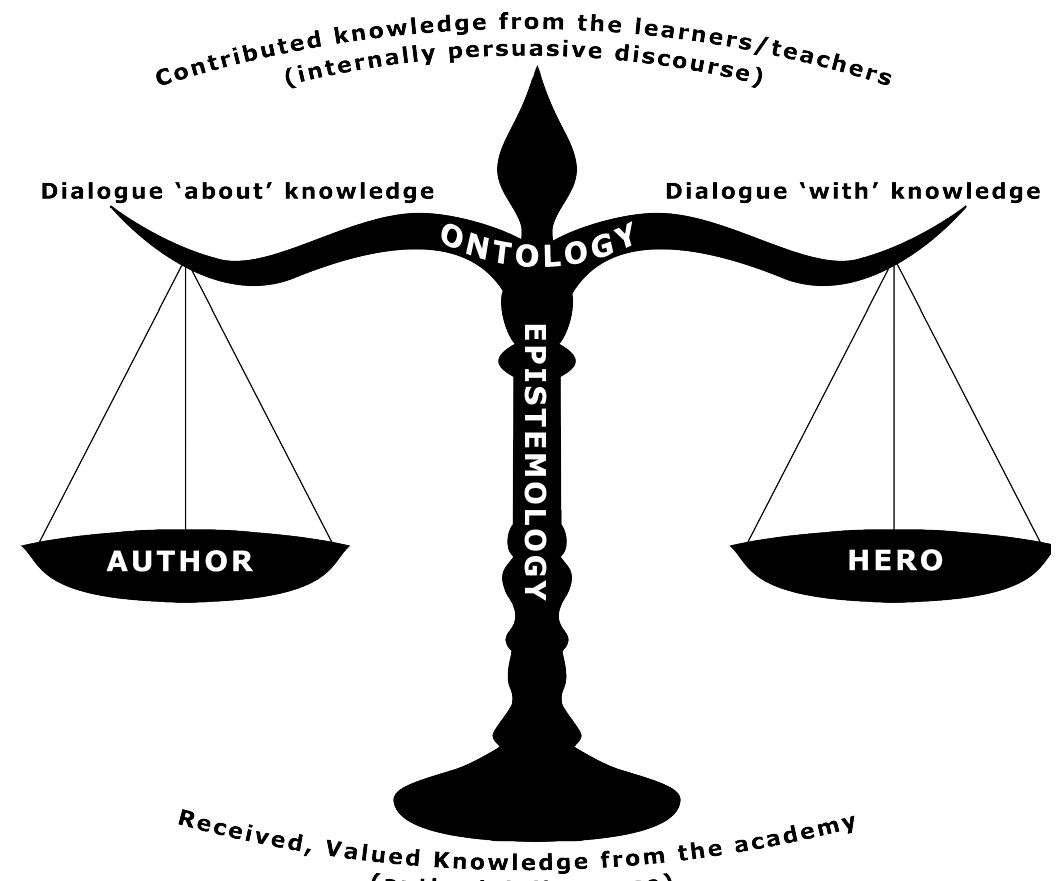
Figure 1: Ballancing the scales - Heroes and Authors in